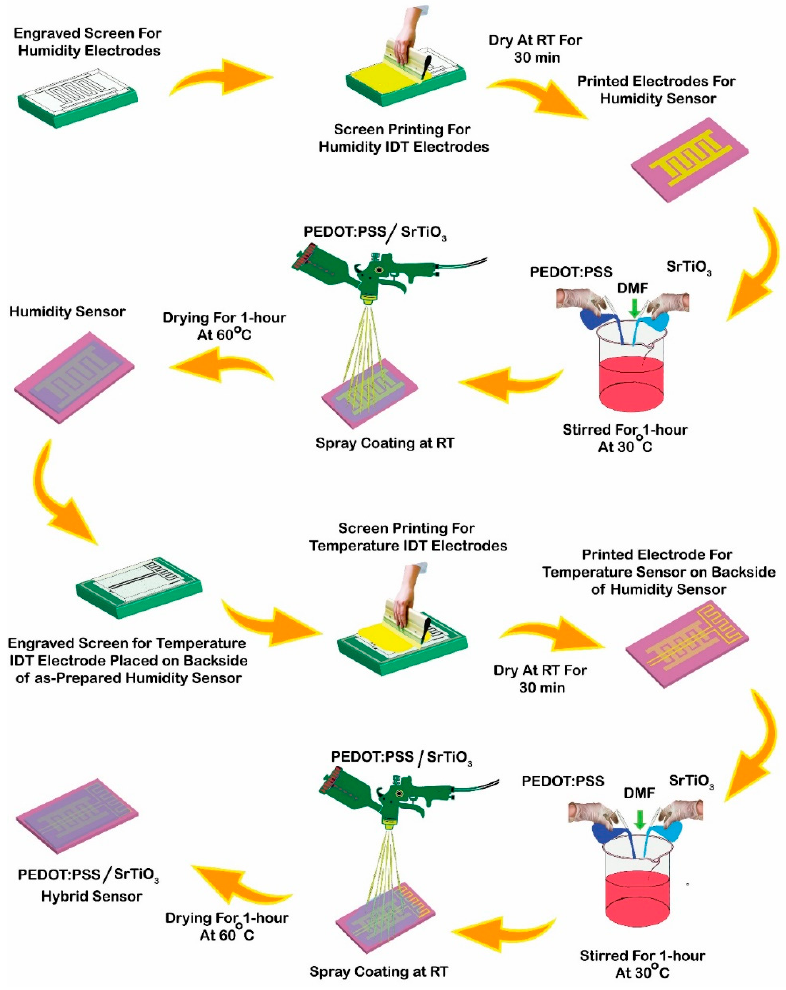
Figure 2. Fabrication process of the hybrid flexible sensor. Designed and engraved screens used